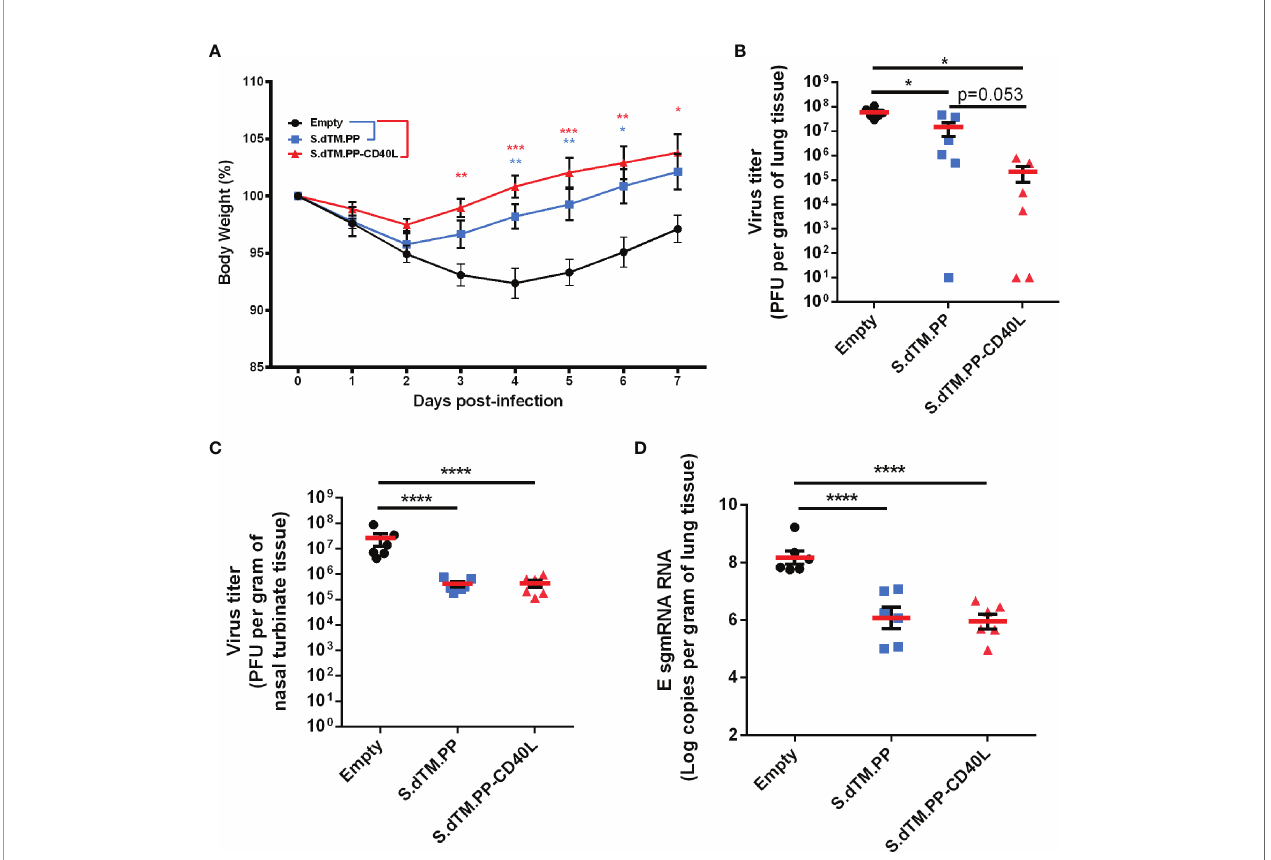
FIGURE 3 | DNA vaccines reduce viral loads and improve weight recovery. (A) Syrian hamster body weight was measured for 7-days following viral challenge (n=6). Viral load in the lungs (B) and nasal turbinates (C) of SARS-CoV-2 challenged hamsters on day 2 post-infection (n=6). (D) Number of E sgmRNA copies in the lungs was determined via RT-qPCR 2 days post-infection (n=6). Data shown is mean±SEM; n = 6 per group. *p < 0.05, **p < 0.01, ***p < 0.001, ****p <